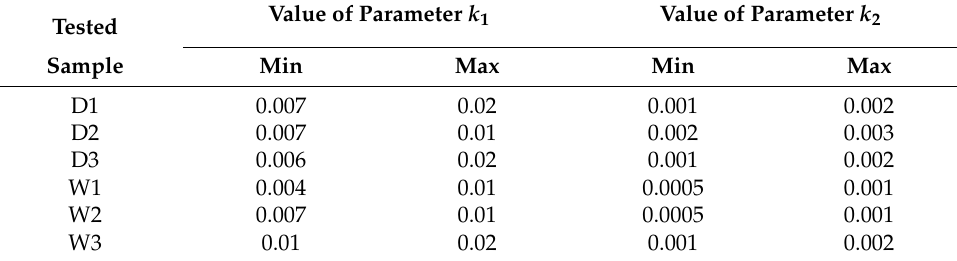
Table 11. Determined coefficients k 1 and k 2 of the equation C ( t ) (17) (TVOC) for each tested dry floor system D1–D3 (29 ◦ C, RH = 50%) and wet W1–W3 (33 ◦ C and RH = 80%) in the range of ACH n = 0.5–1.5 h − 1 .